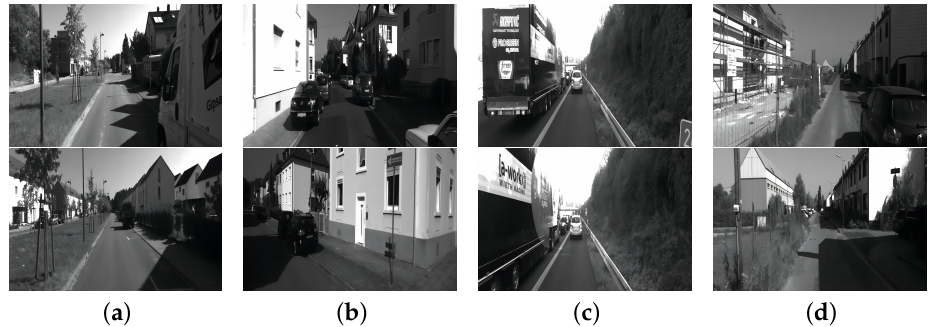
Figure 14. Traffic scene images of KITTI data set, where ( a – d ) are images of different urban and rural roads.